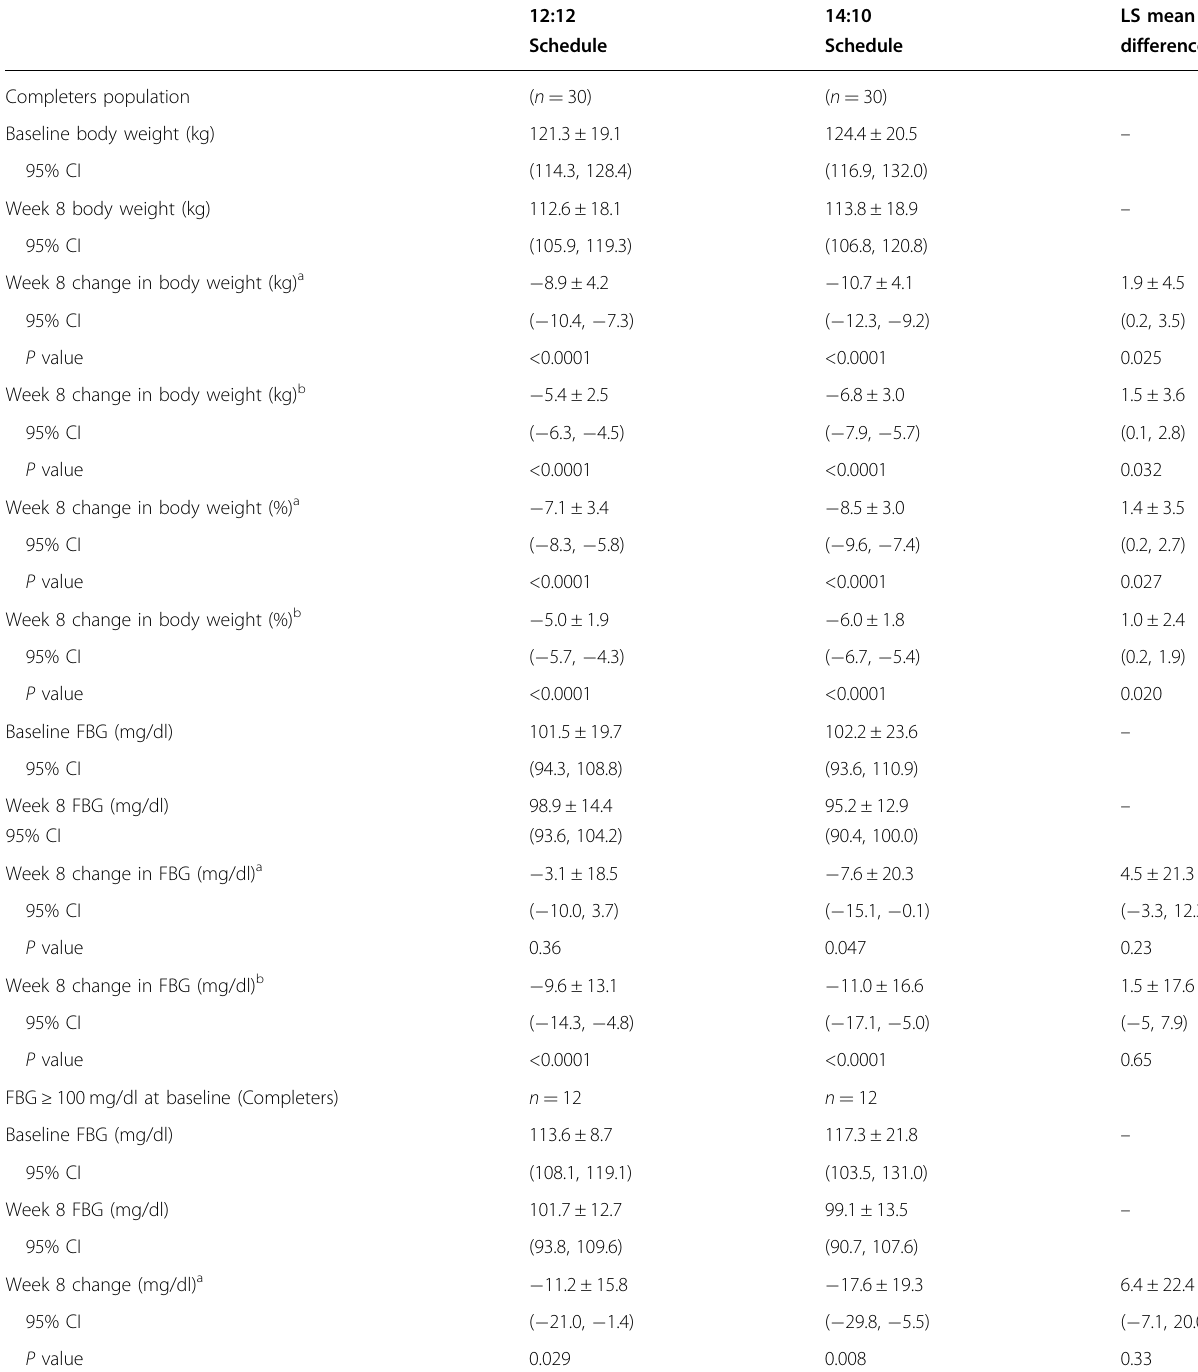
Table 1 Change from baseline in body weight and fasting blood glucose in study